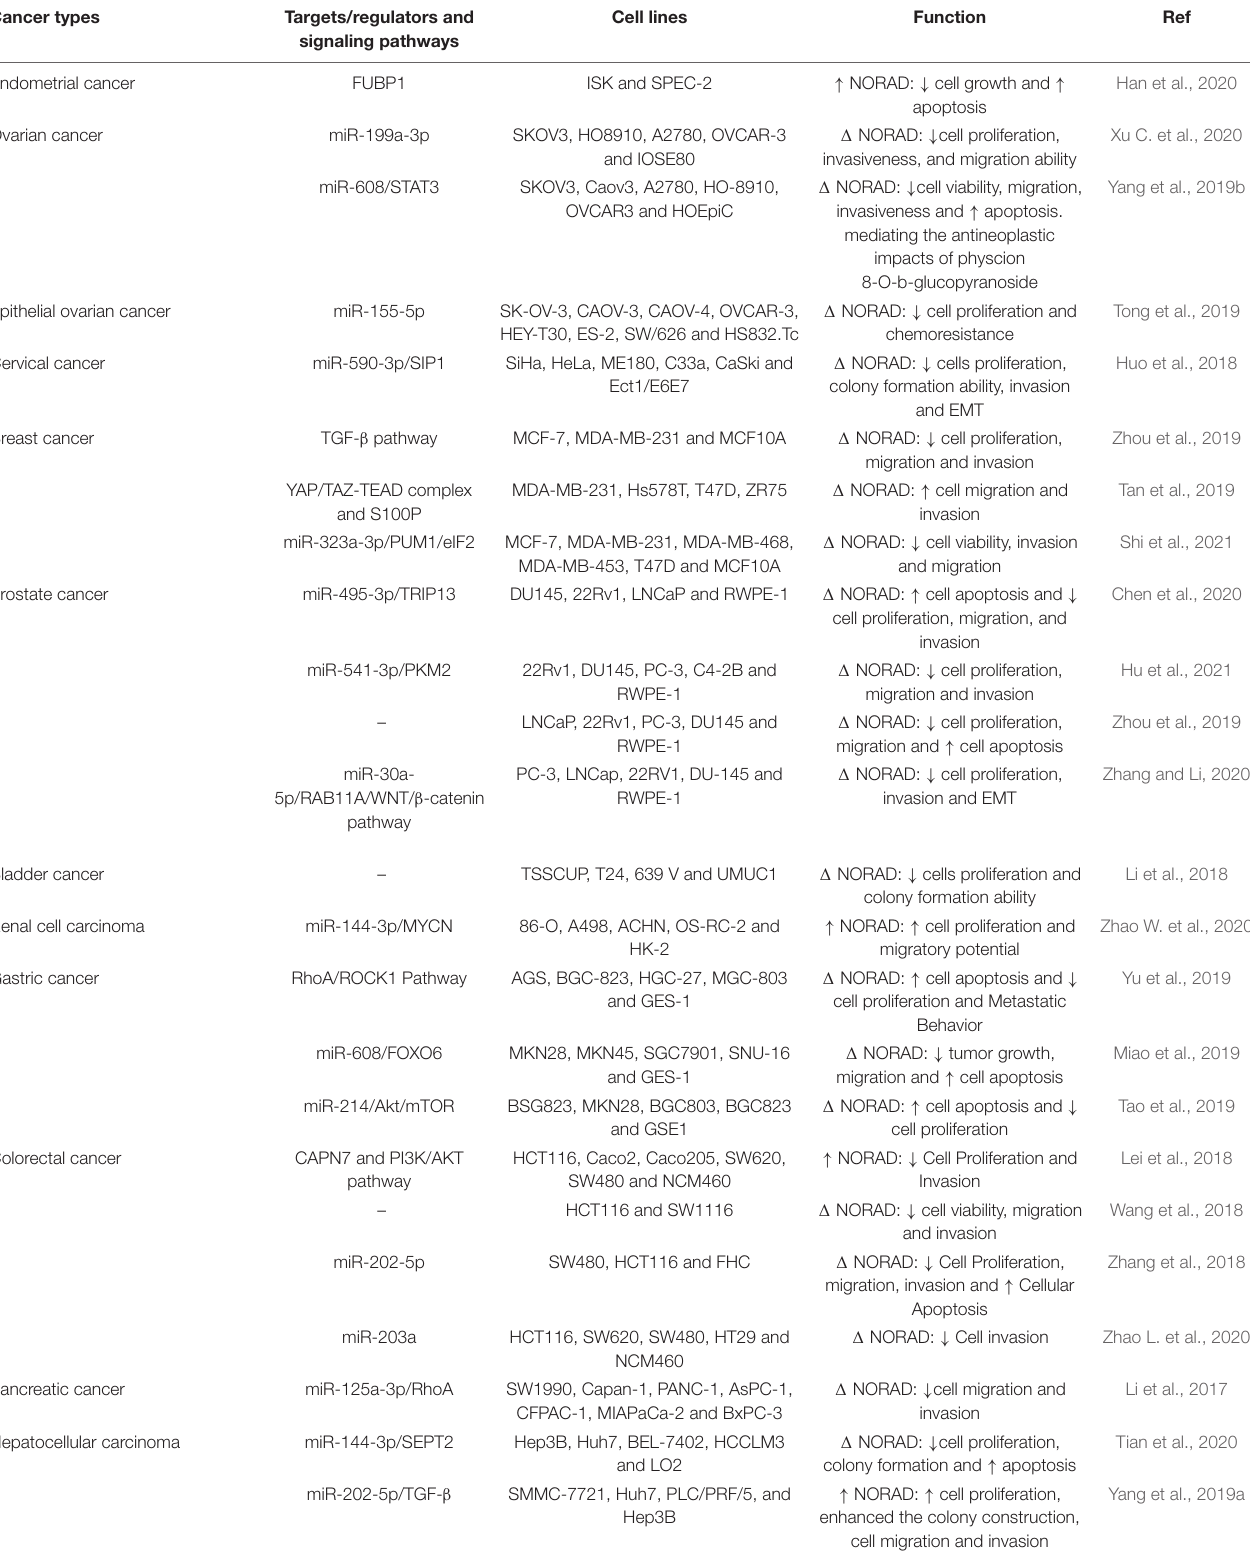
TABLE 1 | Summarized results of studies which evaluated expression of NORAD in cell lines ( (cid:49) : knock-down, EMT: epithelial–mesenchymal